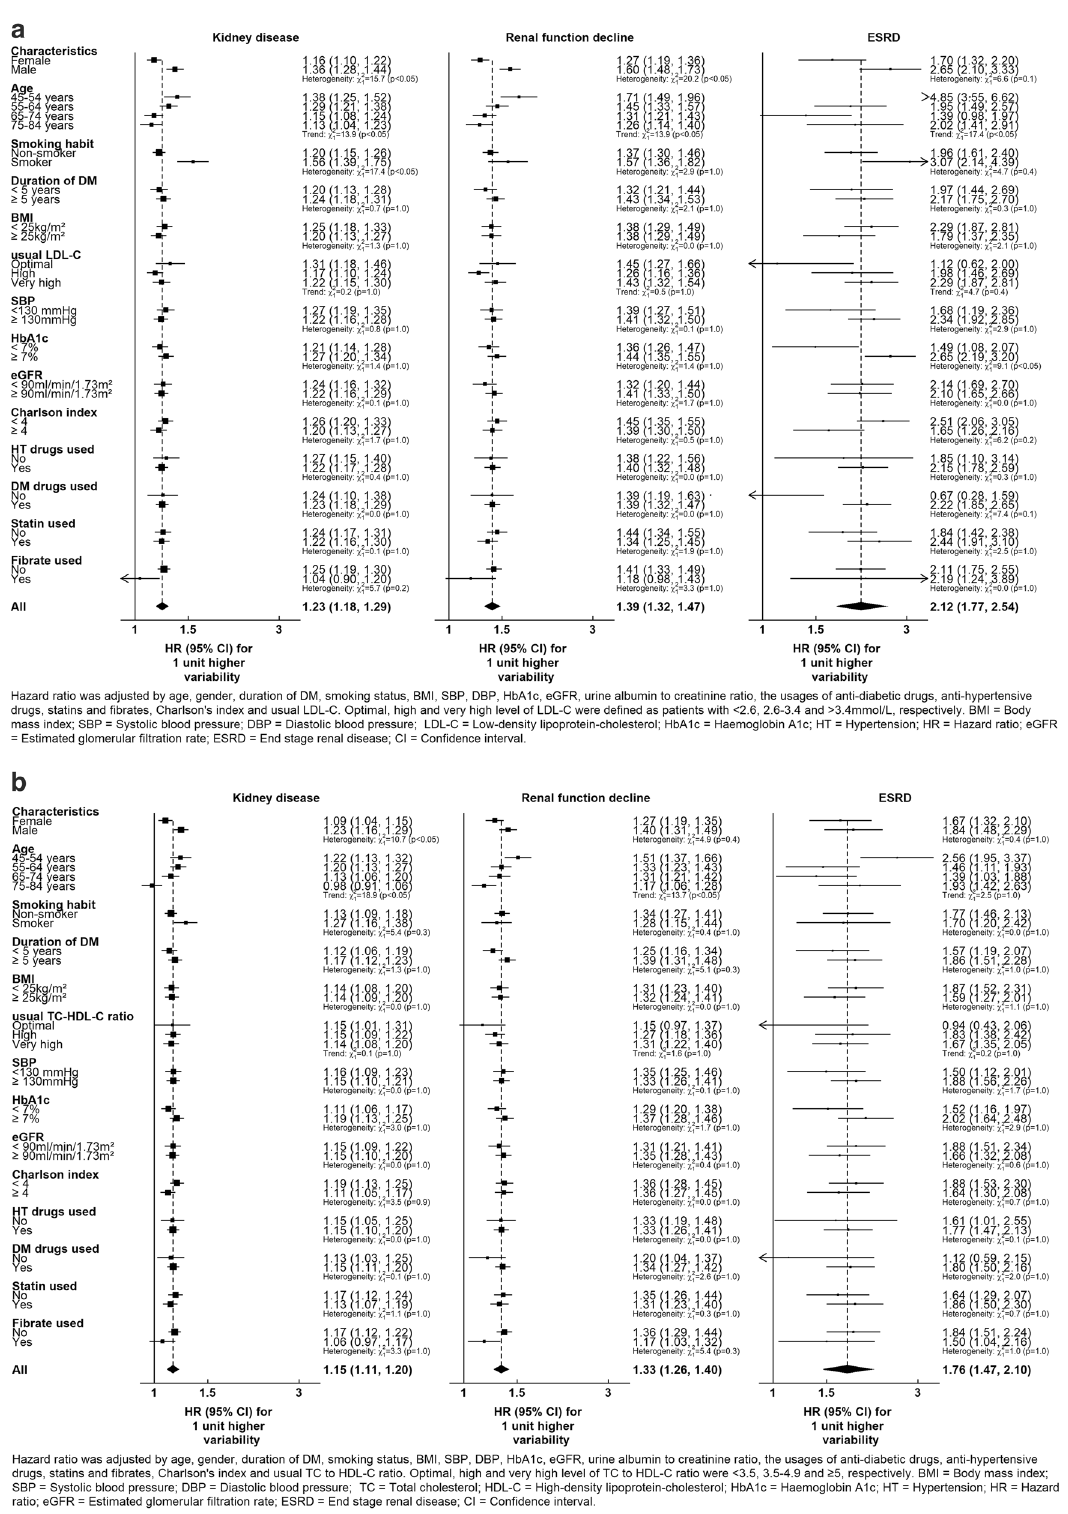
Figure 3. ( a ) Hazard ratios for the association of a unit increase in LDL-C variability with kidney disease, renal function decline and ESRD from Cox regression models adjusted for baseline covariates. ( b ) Hazard ratios for the association of a unit increase in TC to HDL-C ratio variability with kidney disease, renal function decline and ESRD from Cox regression models adjusted for baseline